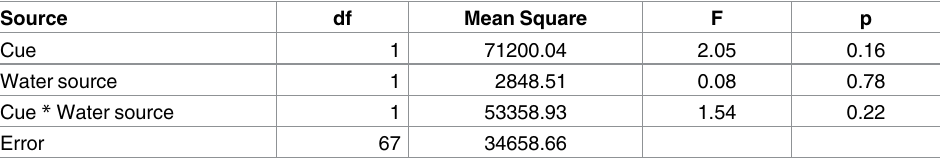
Table 1. Comparison of the total time spent in chambers by Pseudochromis fuscus within y-mazes injected with damage-releasedodours from Pomacentrus amboinensis or a control seawatercue, against a background of either healthy or dead-degraded coral treated water. This may be used as a proxy for motivation; n (healthy water source, damage-released odour) = 19, n (healthywater source,